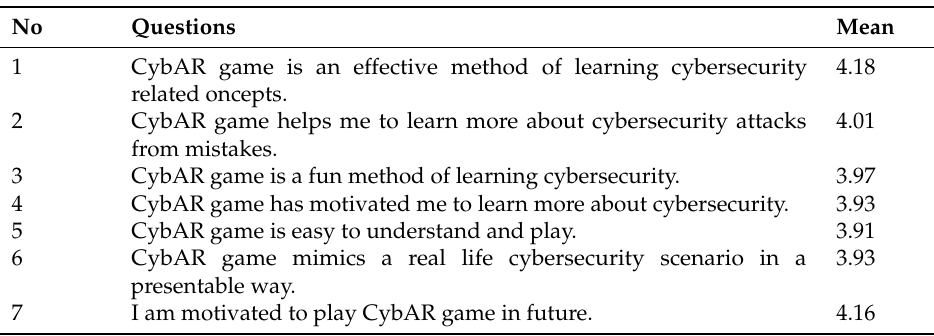
Table 3. Survey items